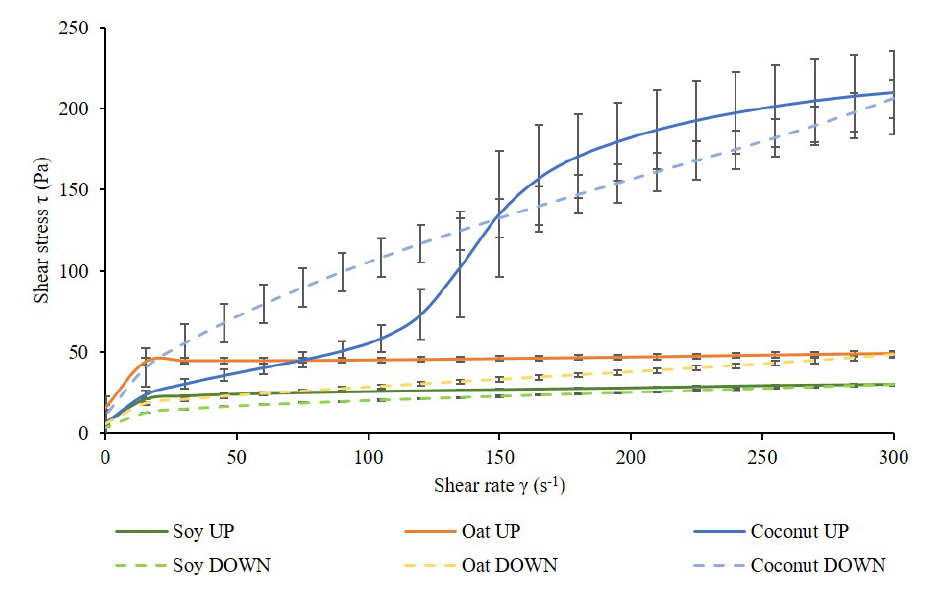
Figure 4. Flow curves under controlled shear rates from 0 to 300 s − 1 and from 300 to 0 s − 1 of fermented soy, oat, and coconut samples. Continuous lines correspond to up-flow and discontinuous lines to